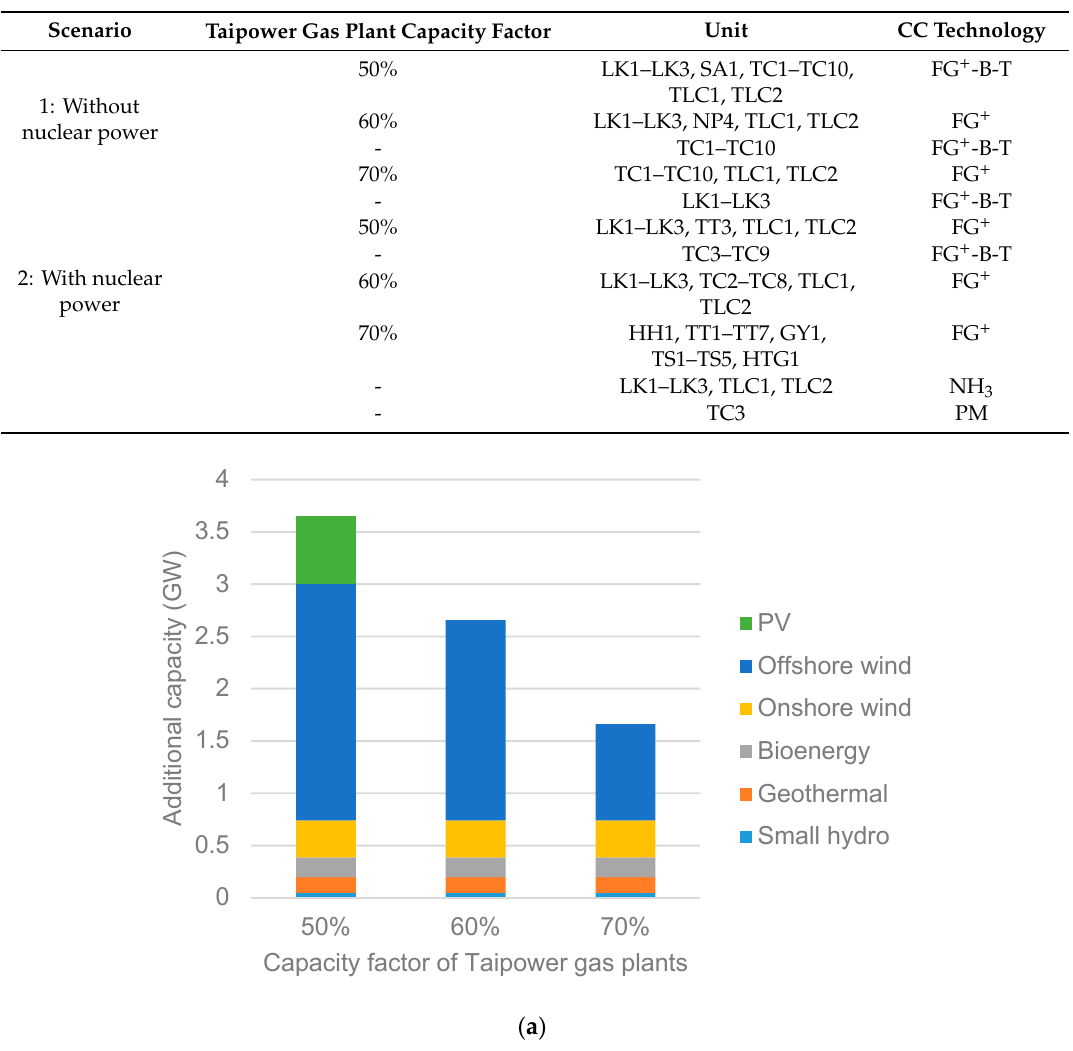
Table 8. CCS retrofits for the case study.